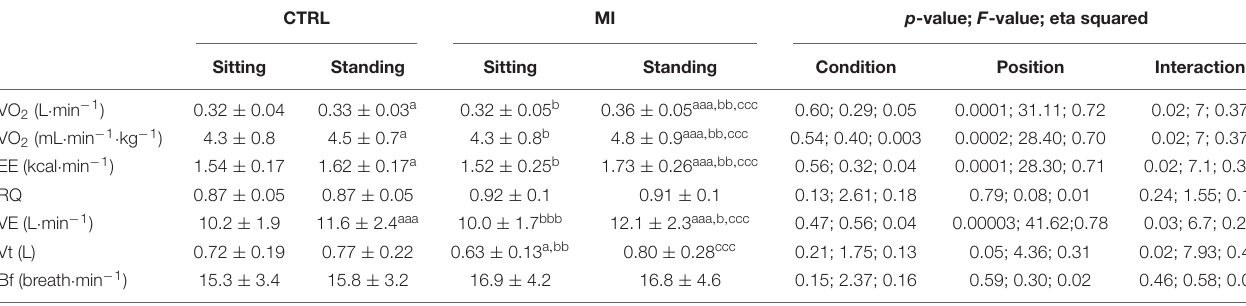
TABLE 2 | Cardiorespiratory and metabolic responses during control (CTRL) and motor imagery (MI) sessions. CTRL MI p -value; F -value; eta squared Sitting Standing Sitting Standing Condition Position Interaction